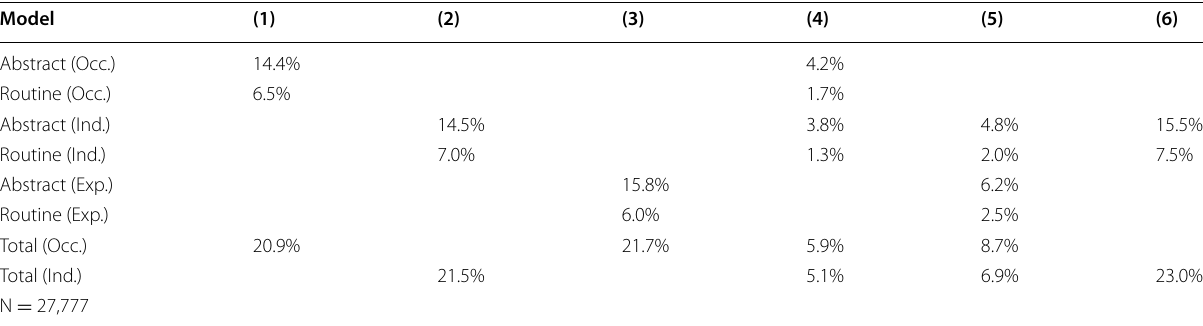
Table 9 Incremental R-squared of task measures